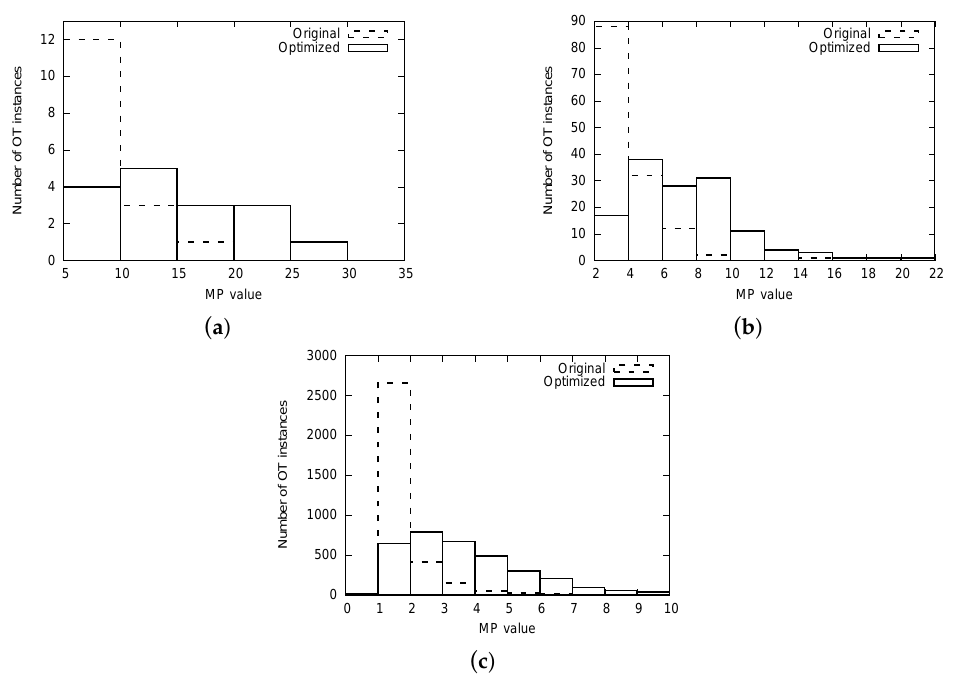
Figure 7. Histograms of the number of OT instances with respect to the MP values. The original MP values of the database in [15] and the ones obtained with our proposed algorithm described in Section 4 are shown. ( a ) Histogram for C 6 ; ( b ) Histogram for C 7 ; ( c ) Histogram for C 8